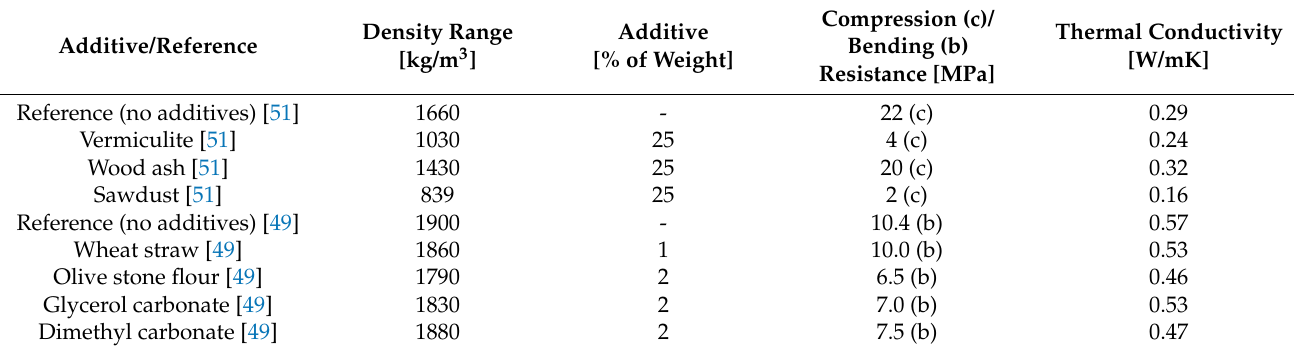
Table 2. Characteristics of bricks with